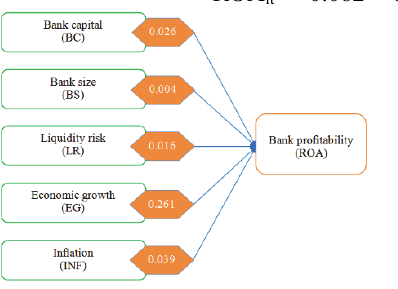
Fig. 1. Stud y model